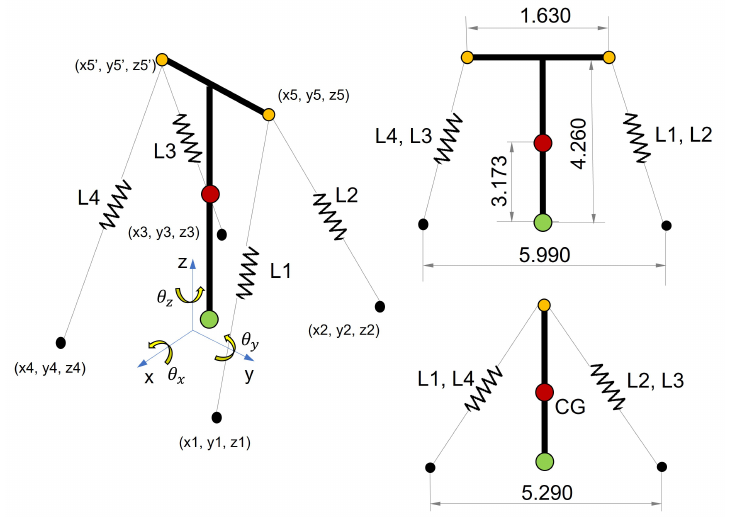
Figure 18. Simplified dynamic model of the tower in LabEDin . Dimensions in